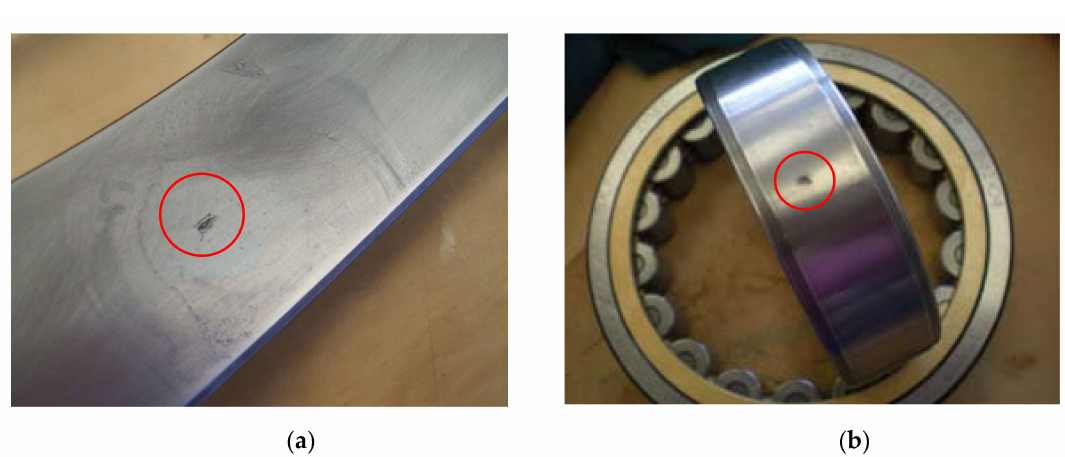
Figure 14. The defect of the tested bearings: ( a ) outer ring defect on FAG-804989 of case 1; ( b ) inner ring defect on SKF NU215 of case